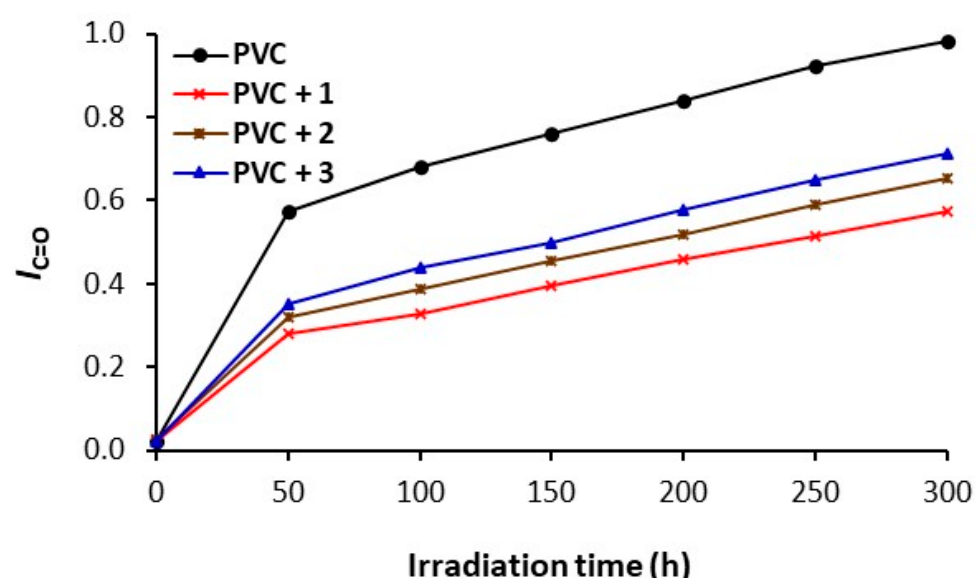
Figure 2. Effect of the time of irradiation on the I C=O of PVC films.